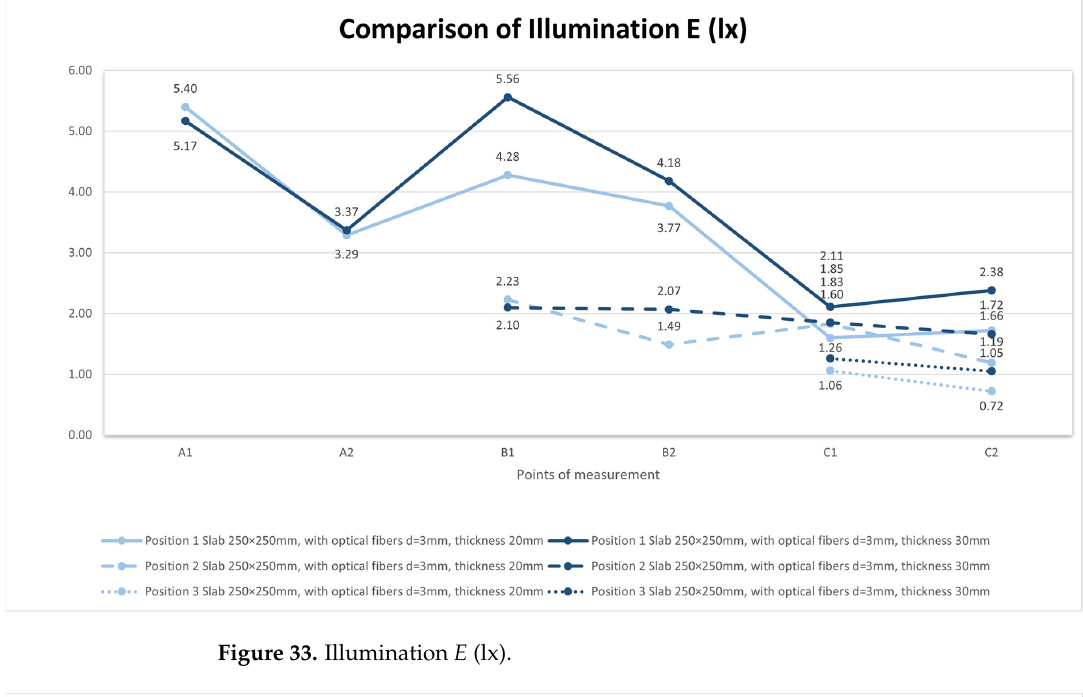
Figure 32. Drawing of measurement points.